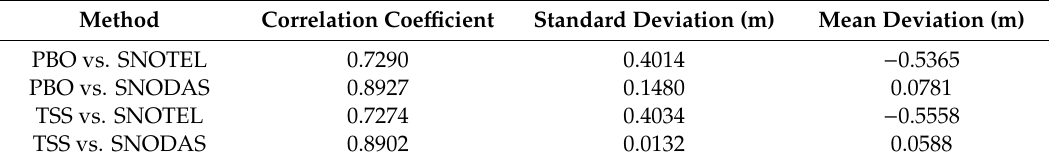
Table 5. Comparisons of snow depth estimates with di ff erent methods at p101 (on tilted